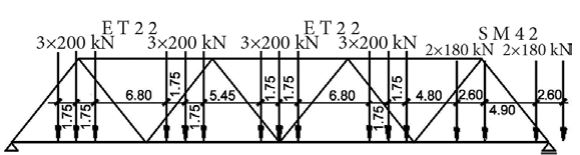
Fig. 8. Analyzed test loading scheme Fig. 9. Computational model of truss